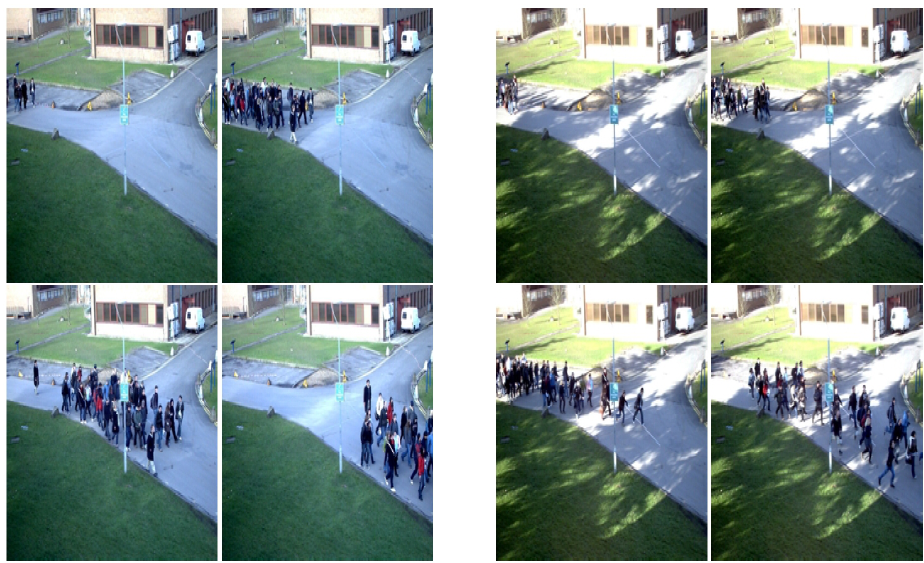
Figure 4. Some sample images from PETS